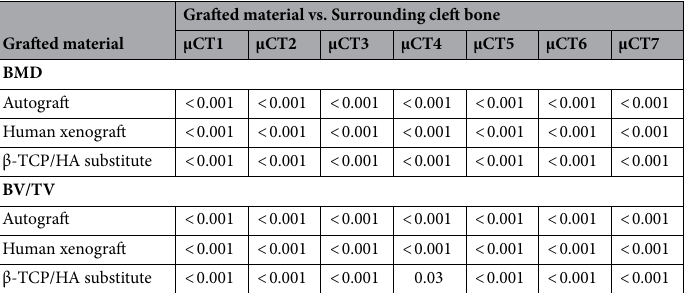
Grafted material vs. Surrounding cleft